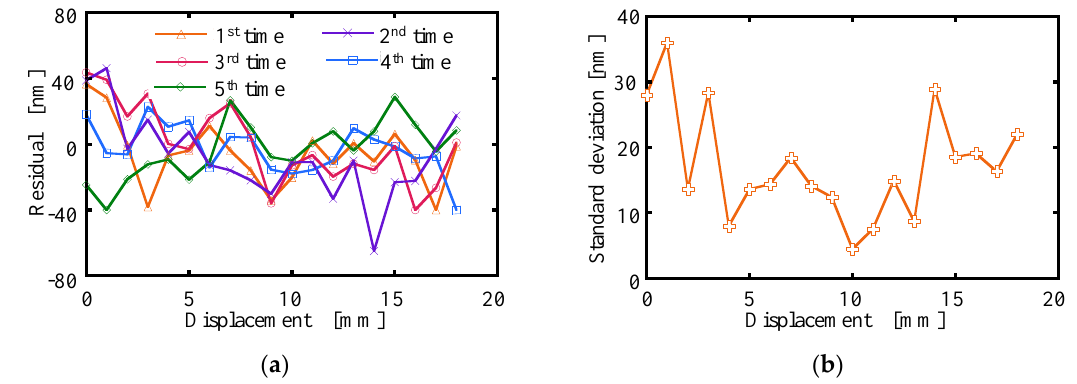
Figure 12. Comparison results: ( a ) residual of measured displacement by the NMM-1 and 3DOFLM systems without wavelength correction; ( b ) standard deviation of five measurements.